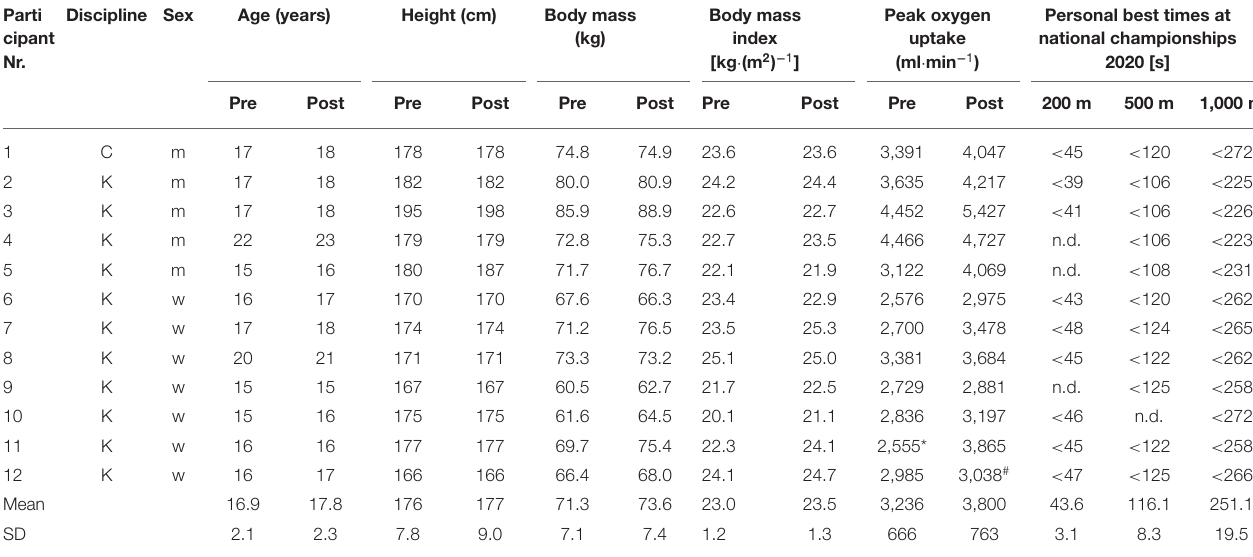
TABLE 1 | Characteristics of the participants before (Pre) and at the end of (Post) the period of observation. Parti cipant Nr.